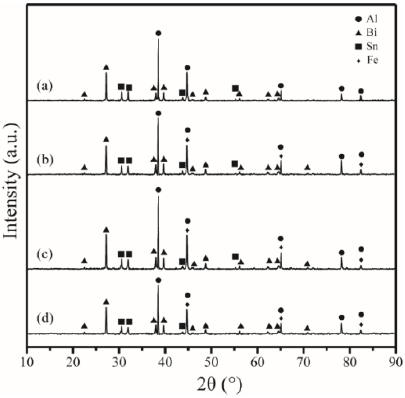
Figure 5. XRD patterns of the prepared composite powders: ( a ) Al-10Bi-7Sn (wt.%) [33]; ( b ) Al-10Bi- 7Sn-0.5Fe (wt.%); ( c ) Al-10Bi-7Sn-1.5Fe (wt.%); ( d ) Al-10Bi-7Sn-3Fe (wt.%).